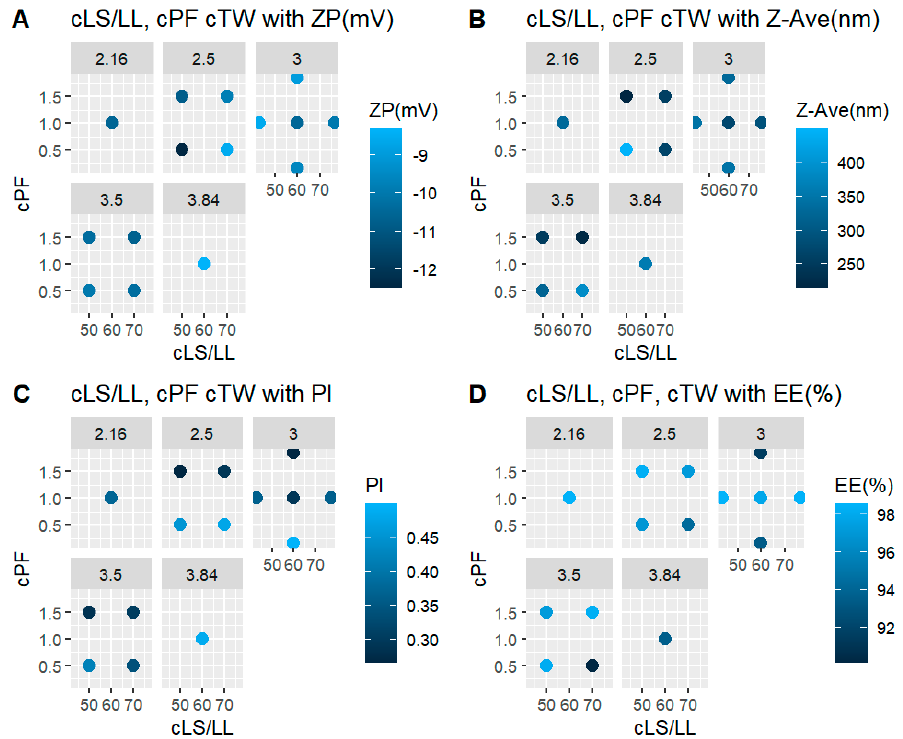
Figure 4. Four-dimensional plots of dependent and independent variables: ( A ) relationship between the independent variables with the zeta potential; ( B ) relationship between the independent variables with the mean particle size; ( C ) relationship between the independent variables with the polydisopersity index; and ( D ) relationship between the independent variables with the encapsulation efficiency.